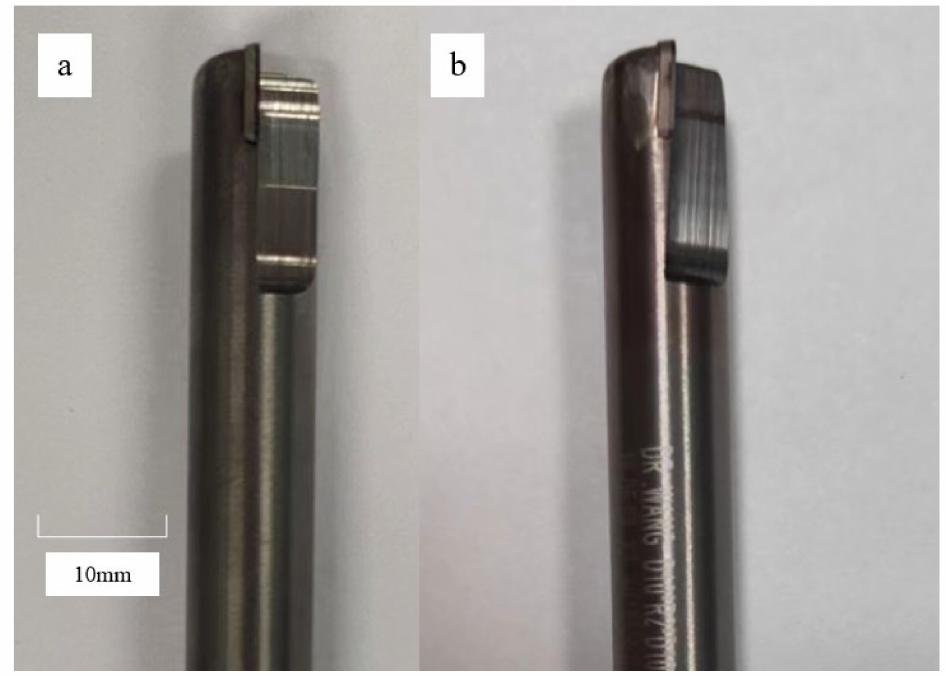
Figure 2. Cutting tools. ( a ) PCD tool with 0 ◦ rake angle; ( b ) PCD tool with 4 ◦ rake